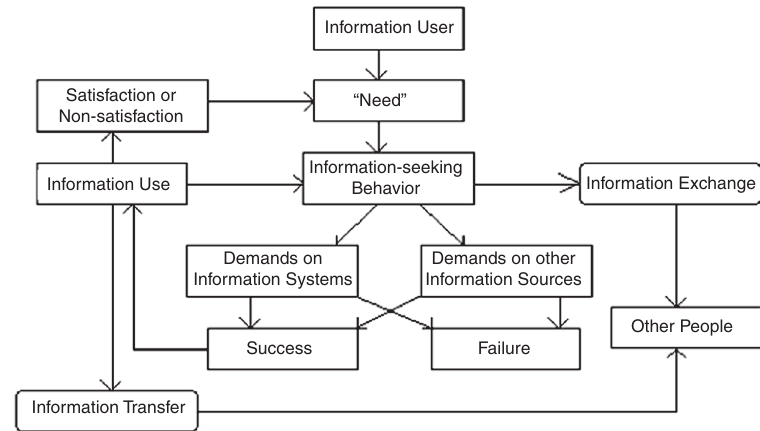
Figure 1. Wilson ’ s information behaviour